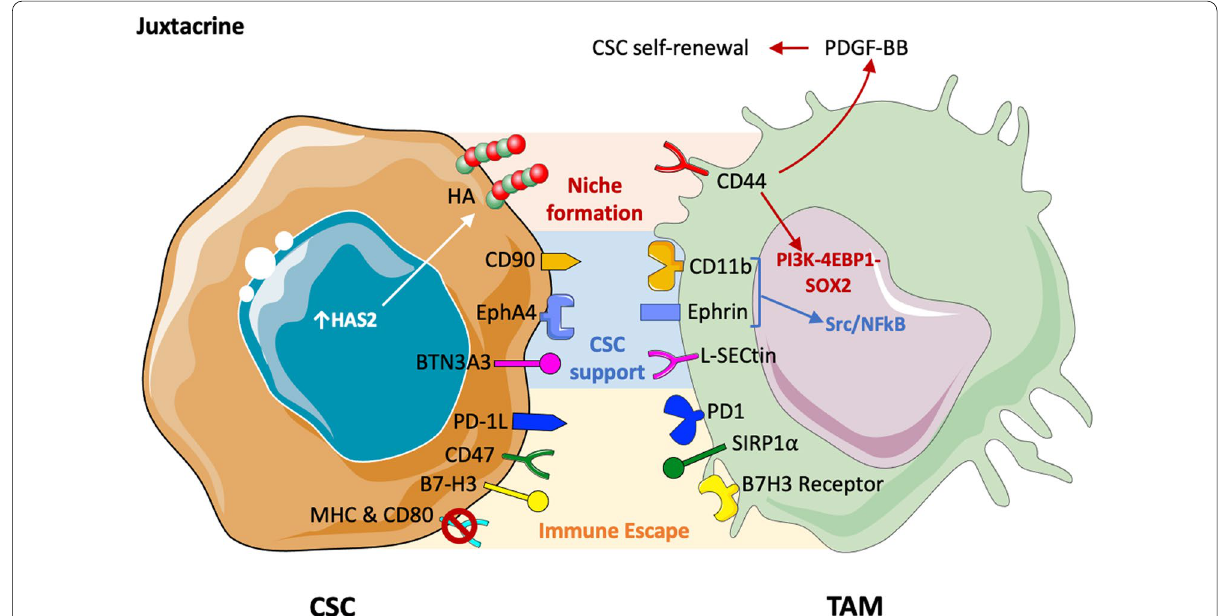
Fig. 2 Juxtacrine mechanisms of interaction between cancer stem cells (CSCs) and tumor-associated macrophages (TAM). CSCs upregulate the enzyme hyaluronan synthase 2 (HAS2), which induces the formation of a layer of pericellular hyaluronan (HA) that facilitates their attachment to TAMs, via the CD44 receptor. Upon this interaction, TAMs produce the growth factor PDGF-BB, which enhances CSC self-renewal; moreover, it activates signaling pathways important for CSC maintenance (e.g.PI3K–4EBP1–SOX2). CSCs express CD90 and the receptor EphA4, which bind to CD11b and Ephrin, respectively. These interactions activate the Src/NFkB pathway, and together with the LSECtin and BTN3A3 they support and drive cancer stemness. Finally, CSCs downregulate MHC molecules and CD80, while upregulating PD-1L, CD47, B7-H3 to escape from the